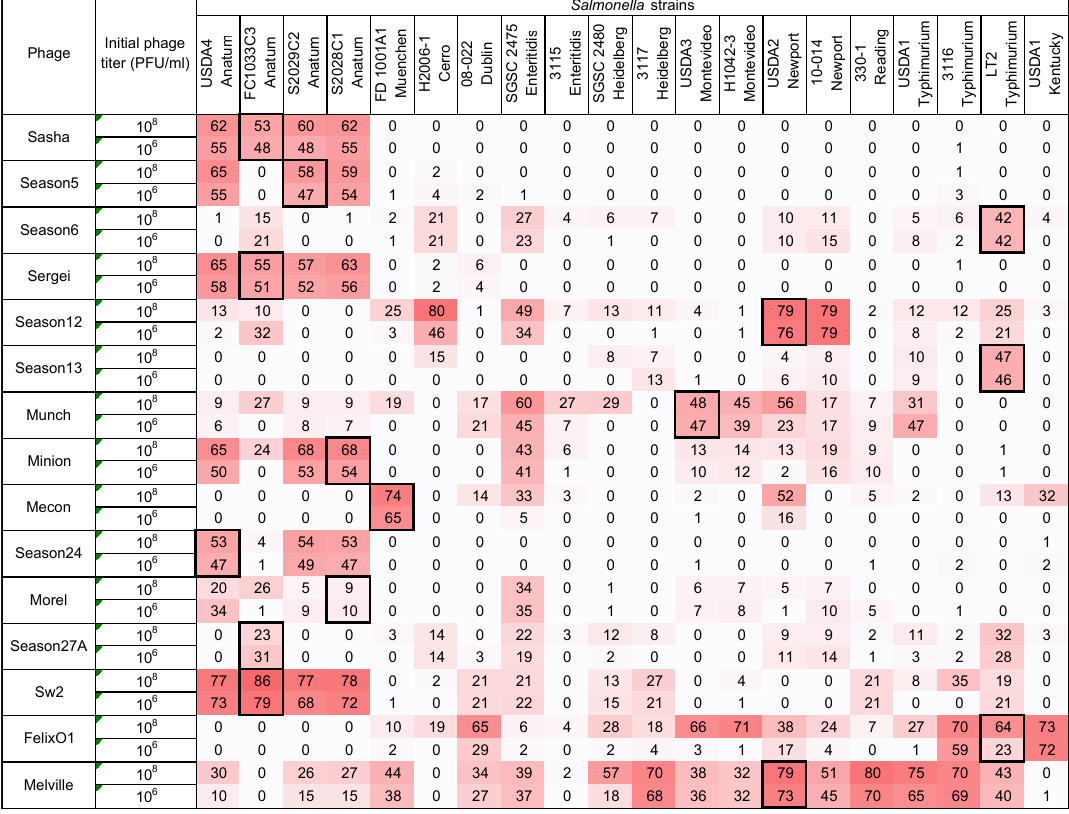
Figure 4. Host range of 15 Salmonella phages against 20 Salmonella strains is determined by the microtiter plate liquid assay at two initial phage concentrations of 10 6 PFU/mL and 10 8 PFU/mL. Values indicate average liquid assay scores calculated by Equation (2) across three replicate experiments. To aid the reader, cells are shaded with stronger color intensity indicating a greater score. Assay score represents the differences in area under the bacterial growth curve with and without phage. Larger numbers indicate a greater suppression of bacterial growth in the presence of phage. Boxed cells indicate the initial isolation and propagation host of the phage. Standard deviations of each experimental unit across this assay ranged from 0.03 to 10.89. Negative values falling within one standard deviation were adjusted to zero for the convenience and for calculating the following comparison between two host range